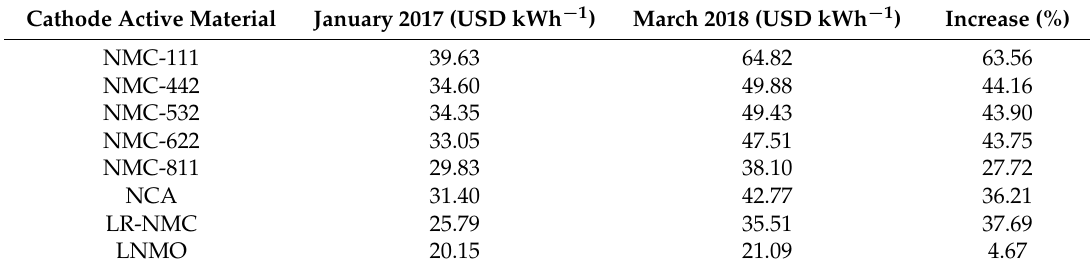
Table 3. Total price increase comparison of cathode active materials examined by CellEst from